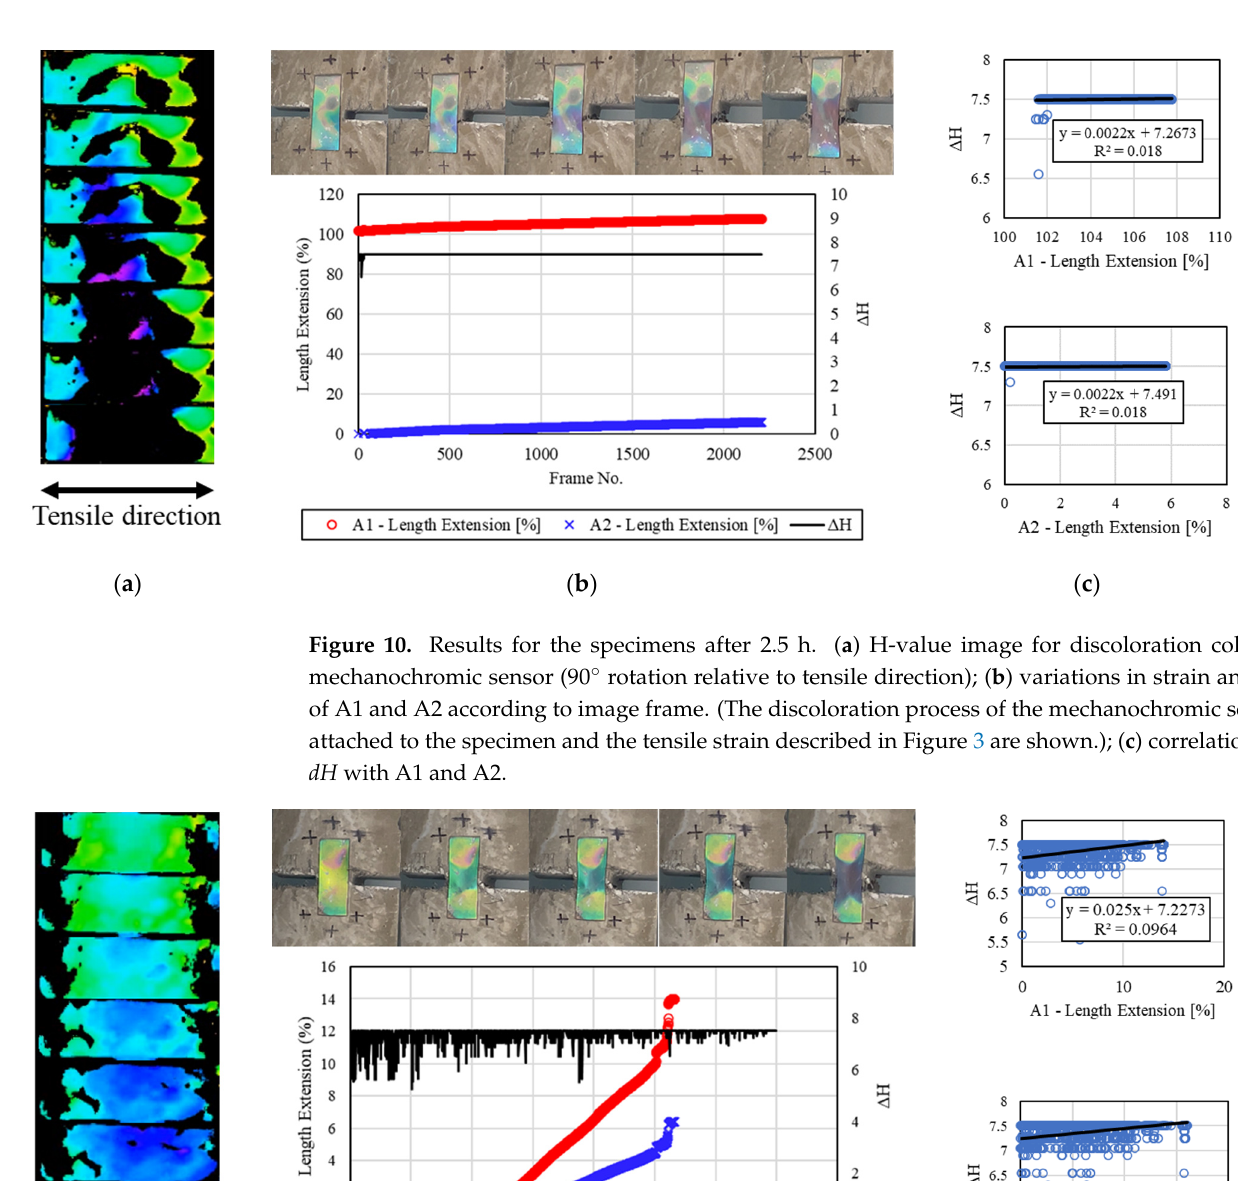
( c ) Figure 9. Results for the specimens after 2.0 h. ( a ) H-value image for discoloration color of mecha- nochromic sensor (90° rotation relative to tensile direction); ( b ) variations in strain and dH of A1 and A2 according to image frame. (The discoloration process of the mechanochromic sensor at- tached to the specimen and the tensile strain described in Figure 3 are shown.); ( c ) correlations of dH with A1 and A2. 4.1.6. Specimens 2.5 h after End of F–T Figure 10 presents the results of analyzing the relationship between the deformation of the concrete specimen and the discoloration reaction of the mechanochromic sensor 2.5 h after the end of freezing and thawing. The surface condition of the specimen and the image analysis results are shown. The sensor surface was cleaned after the end of the freeze–thaw test, and image capture/analysis was conducted. Areas close to the adhesion parts of the sensor lost discoloration reactivity. Although there were yellow areas that lost